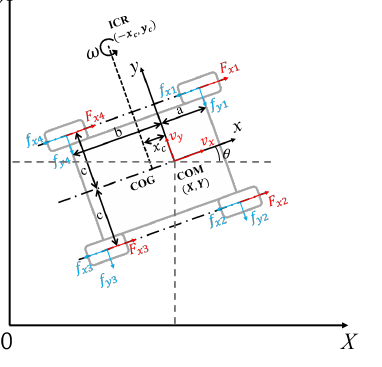
Figure 2. Four wheeled skid steered vehicle dynamics